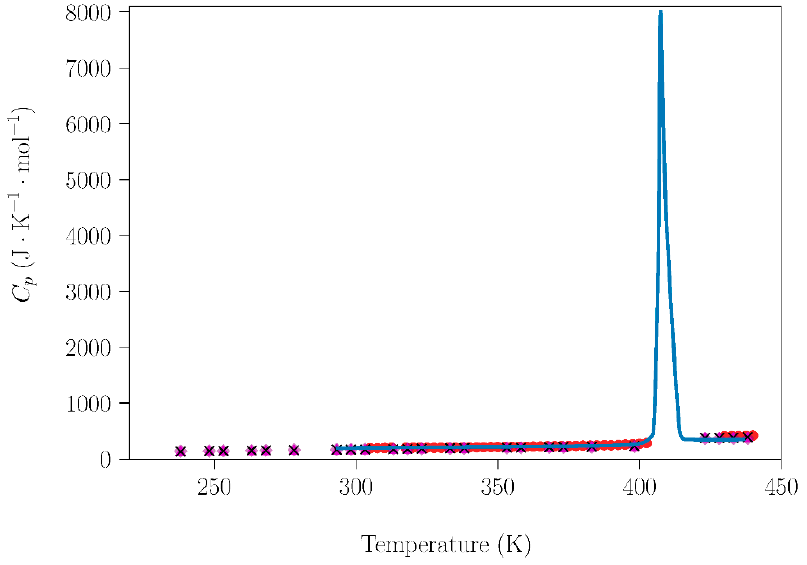
Figure 5. Dependence of molar heat capacity of TRIS on temperature from 223 K up to 433 K (heating rate 2 K·min − 1 ). Blue circles are the experimental results for the TRIS handled under laboratory conditions. Red circles [31], green squares, purple rhombus, pink triangles, and black crosses [29] are literature data acquired using different methods for samples prepared under dry conditions in a glove box.